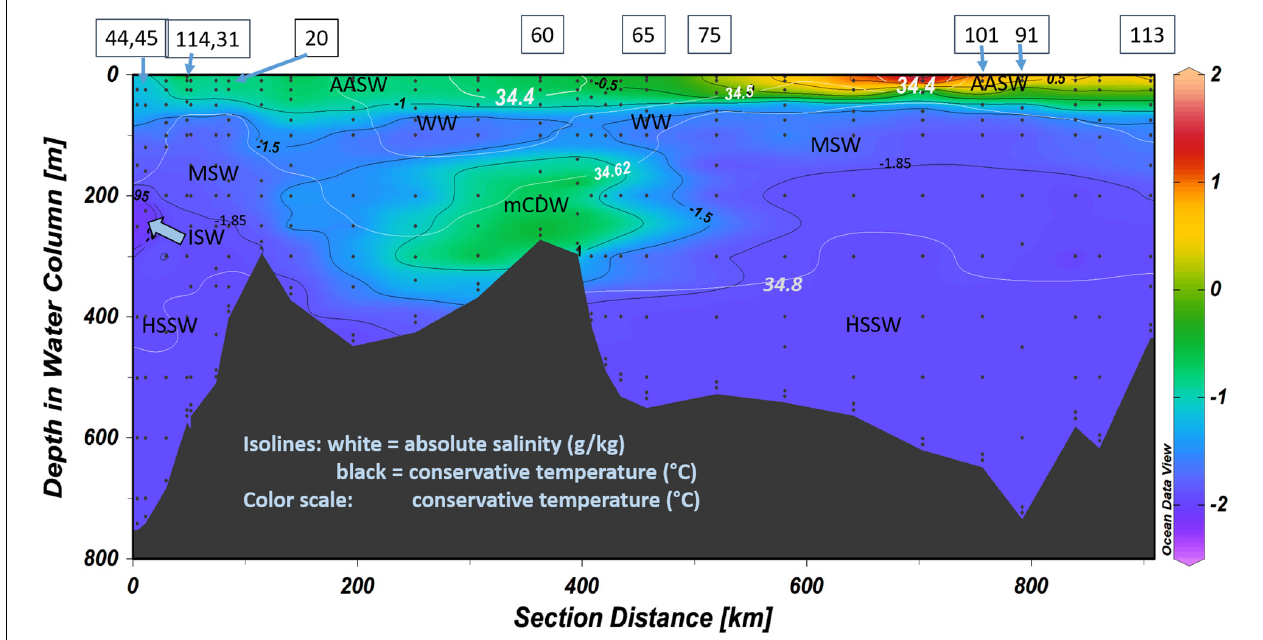
FIGURE 2 | Conservative temperature ( ◦ C) in the circle transect ( Figure 1 ). Black isolines indicate temperatures used for defining the water masses. White isolines show absolute salinity (g kg − 1 ), with values used also for defining water masses. Some station numbers are given on top of the figure. The sequence of stations where trace metals were sampled and analyzed from right to left is: 44, 45, 43, 114, 31, 30, 20, 46, 47, 48, 49, 59, 60, 61, 62, 63, 64, 65, 75, 85, 86, 87, 101, 91, 111, 112, and 113. Stations 16–18 and 88–90 are outside this transect (see Figure 1 for their positions). AASW = Antarctic Surface Water, WW = Winter Water,